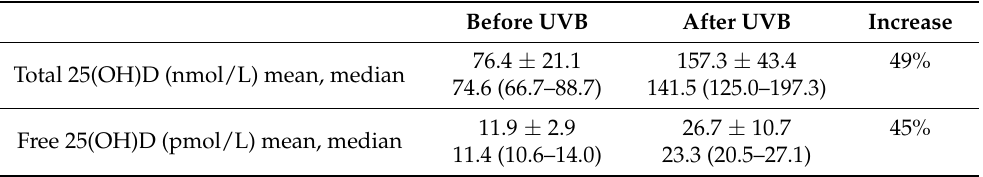
Table 3. Total and free 25(OH)D levels before and after NB-UVB in atopic dermatitis patients. Mean values ± standard deviation (SD) and median values with inter quartile range (IQR) are presented. Percentage increase is based on mean values. Before UVB After UVB